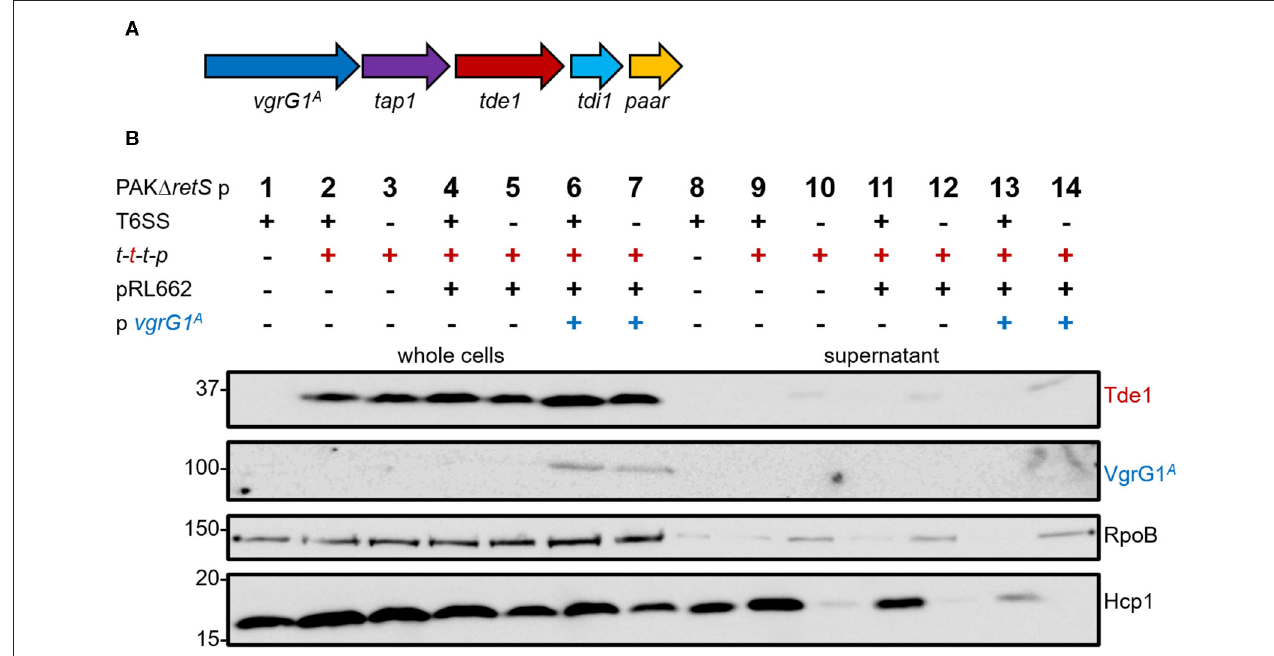
FIGURE 1 | P. aeruginosa cannot perform heterologous secretion of A. tumefaciens VgrG1 A and Tde1. (A) The set of genes tap1-tde1-tdi1-paar (purple-red-cyan-orange) were expressed from pTrc200, while vgrG1 A (blue) was expressed from pRL662 in P. aeruginosa (Bondage et al., 2016). (B) Representative figure of a western blot from a secretion assay of PAK 1 retS pTrc200 (p) with an active ( + ) or inactive (–) H1-T6SS expressing ( + ) tap1-tde1-tdi1-paar ( t-t-t-p ) or containing pRL662 ( + ) with vgrG1 A ( + ). Antibodies used (from top to bottom) are against Tde1, VgrG1 A , RpoB, and Hcp1 as indicated on the right.